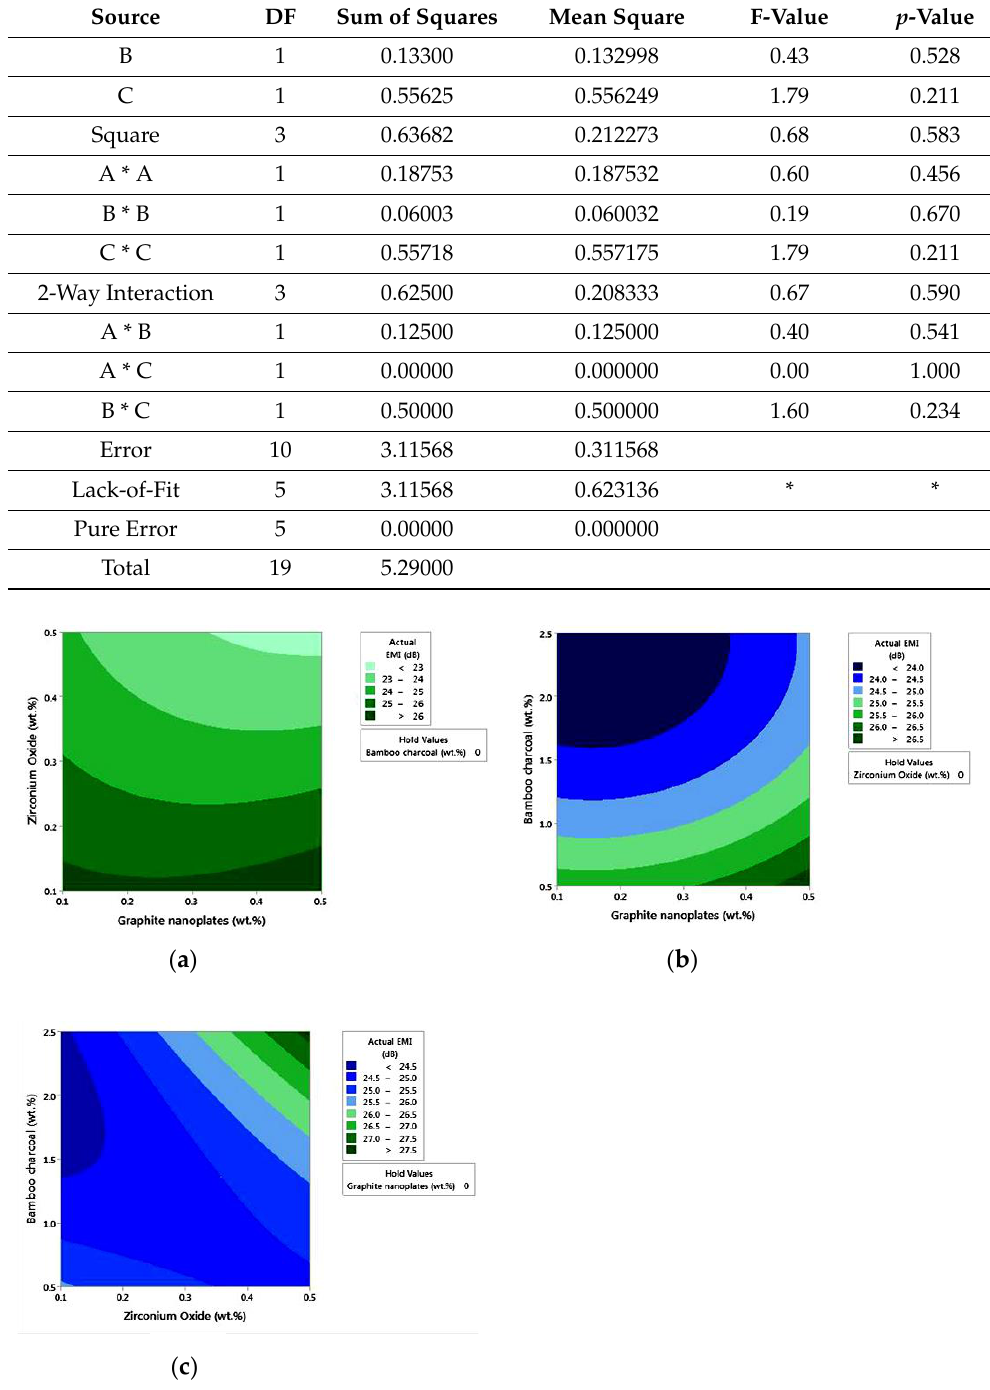
Figure 6. Contour plots displaying the impact of ( a ) GNP and ZrO 2 on EMI effect, ( b ) GNP and BC on EMI effect, ( c ) BC and ZrO 2 on EMI effect.